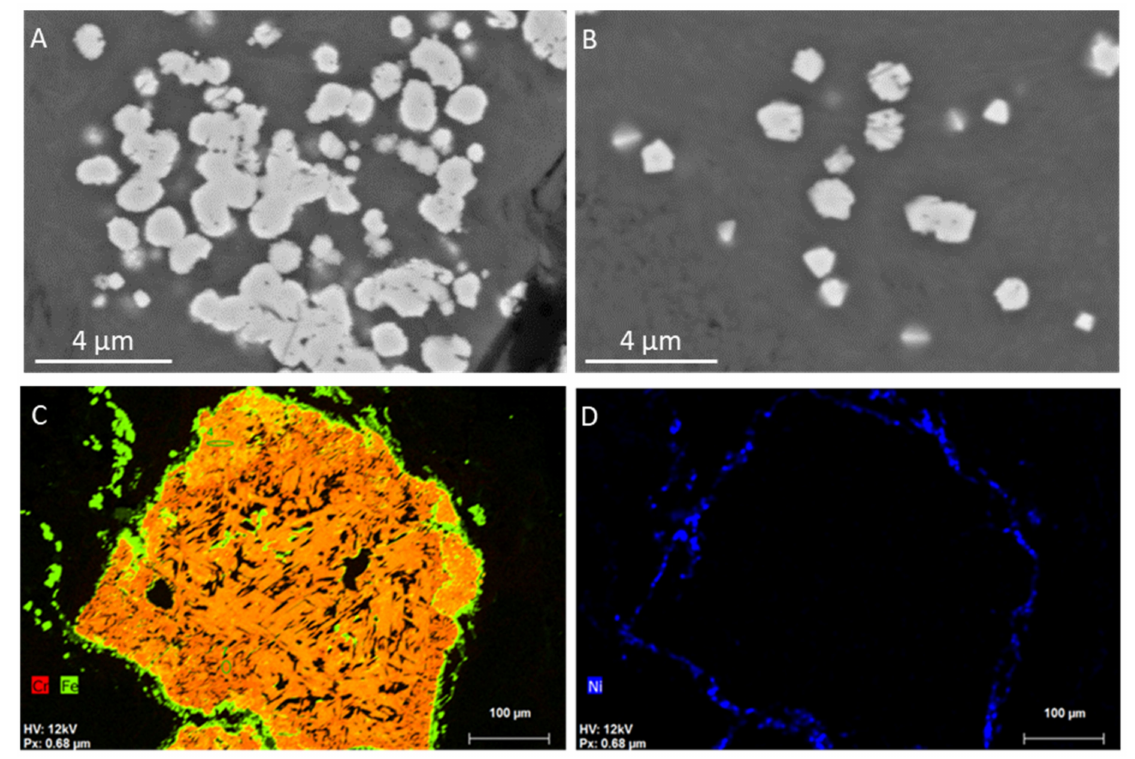
Figure 9. ( A , B ) SEM backscatter electron (BSE) images of small neoformed grains of Co enriched magnetite within a serpentine matrix within the serpentinite protolith. ( C , D ) Element maps (( C EDX) red = Cr; green = Fe; ( D ) blue = Ni) of highly altered relict chromite grains with outer rims of newly formed Ni enriched